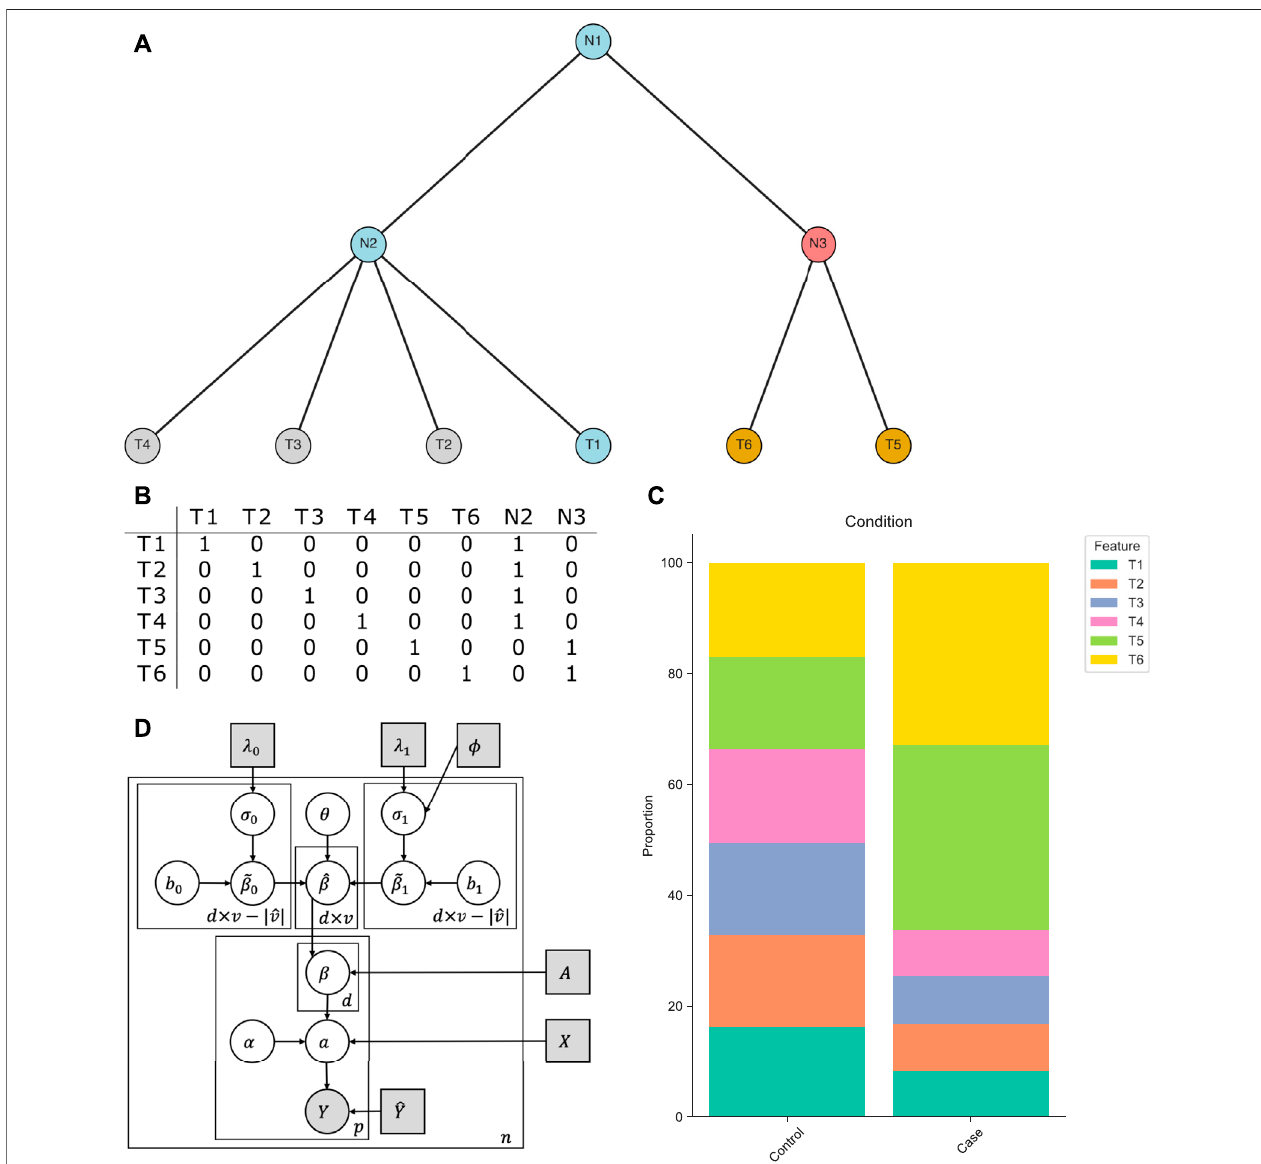
FIGURE 1 | Intuition behind tascCODA. (A) A multifurcating tree structure T with internal nodes N1, N2, N3, and tips T1 ... T6. tascCODA decides whether modelingthechangeofabundanceofasubtree(e.g.nodesT5,T6-gold).asacommoneffectattheircommonancestor(e.g.,N3-red)ispreferable.ThebluenodesT1, N1,andN2arereferencenodesinthisexample. (B) Ancestormatrixofthetreein (A) . (C) ExampledatasetwheretheabundancesofT5andT6increaseinthesameway between conditions (relative to the reference T1). Here, a group-level effect on N3 would be the preferred option. (D) Plate representation of the tascCODA model. Grey squares indicate fi xed parameters and input variables that are either part of or directly calculated from the data. The grey circle represents the output count matrix, white circles show latent